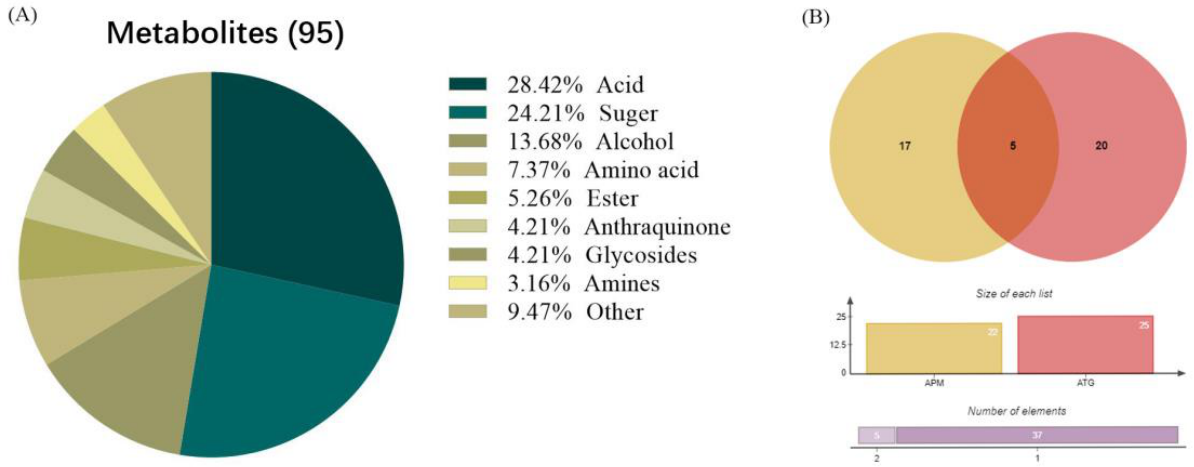
Figure 4. Identification results of non-targeted metabolomics: ( A ) classification of compounds and ( B ) Venn diagram description of differential compounds.